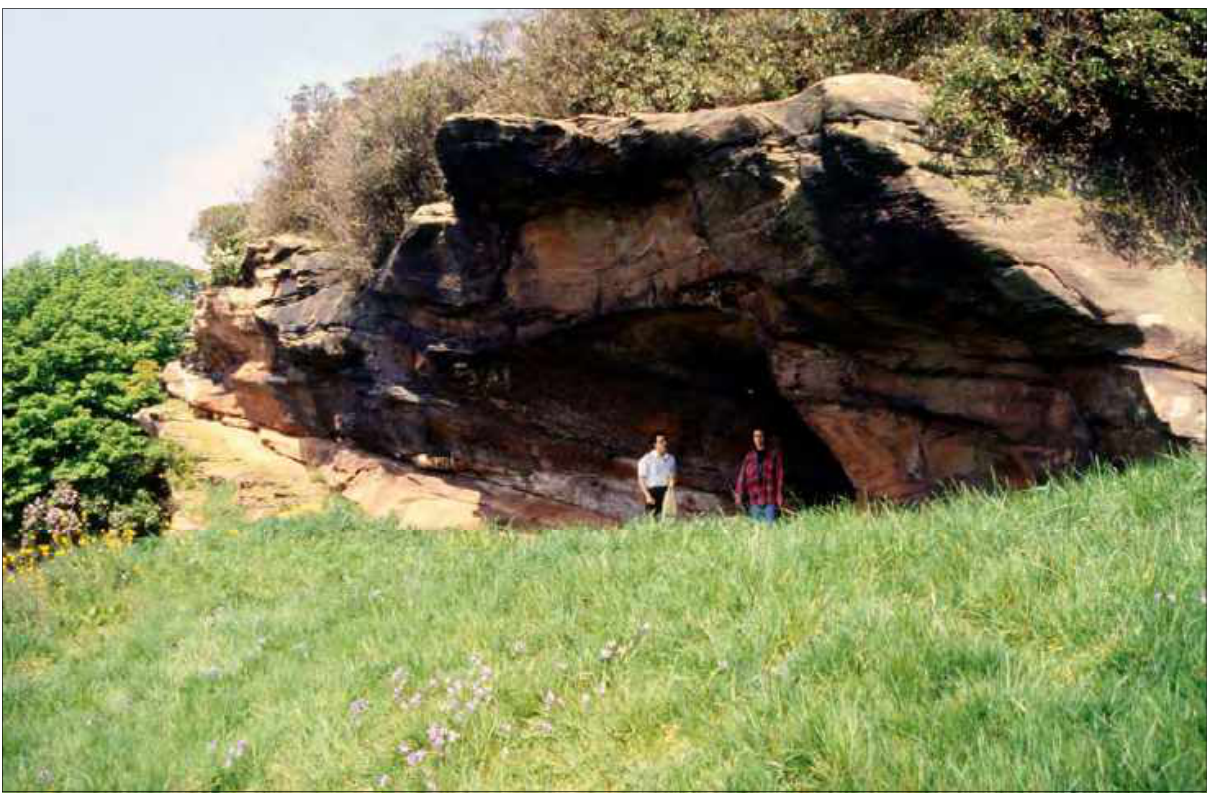
Fig 2.2 The possible Late Upper Palaeolithic rockshelter at Carden Park (Chester